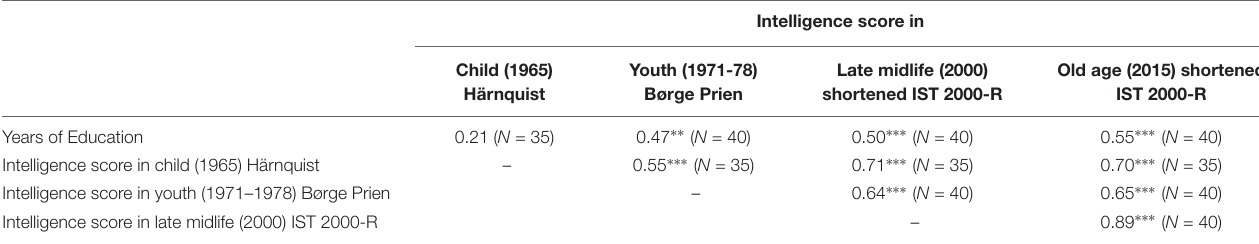
TABLE 2 | The results of Pearson correlation coefficients between the intelligence test scores obtained in childhood, youth, late midlife, and in elderly age (i.e., the present, and years of